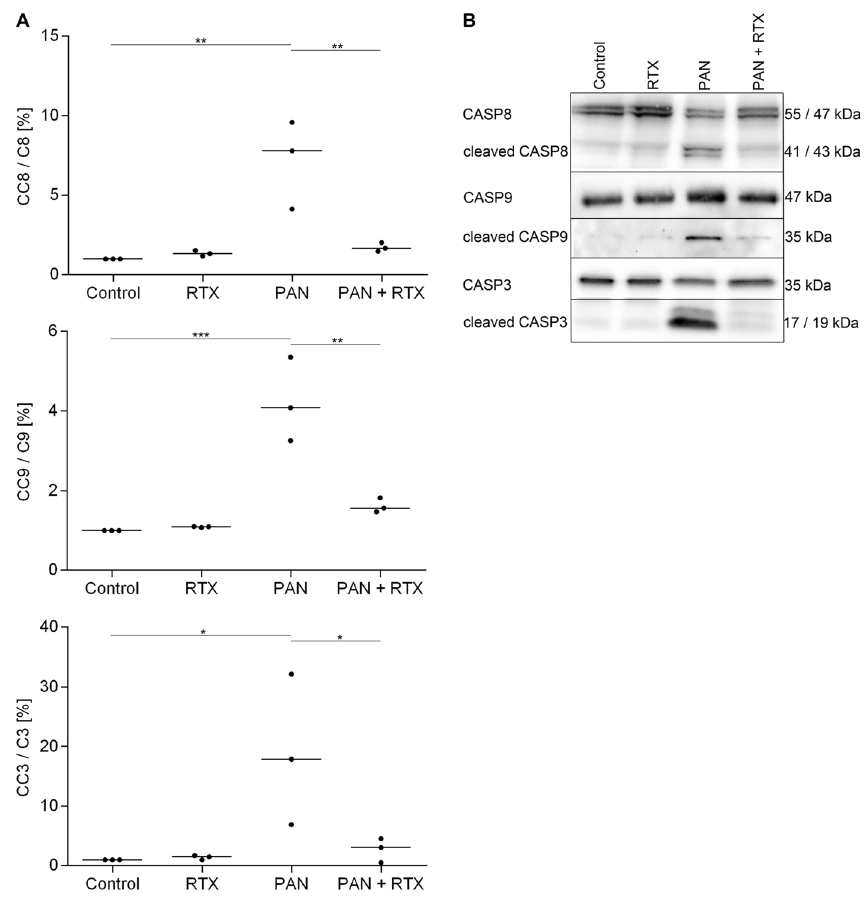
Figure 4. Rituximab prevents activation of cleaved Caspase proteins in human podocytes. Western-blot analysis to measure the activation levels of Caspase-8, -9 and -3. ( A ) For quantification the amount of active cleaved Caspase proteins were normalized with respect to total Caspase levels. Statistics: One-way ANOVA with Tukey’s multiple comparisons test; the median [%] is shown; *p < 0.05; **p < 0.01; ***p < 0.001; n = 3 experiments. ( B ) The Caspase blot images shown are representative examples from 3 independent experiments. Caspase-8, -9 and -3 = total Caspase protein levels, cleaved Caspase-8, -9 and -3 = active Caspase proteins. CC8 = cleaved Caspase-8; C8 = total Caspase-8; CC9 = cleaved Caspase-9; C9 = total Caspase-9; CC3 = cleaved Caspase-3; C3 = total Caspase-3; RTX = rituximab (100 µg/ml); PAN =